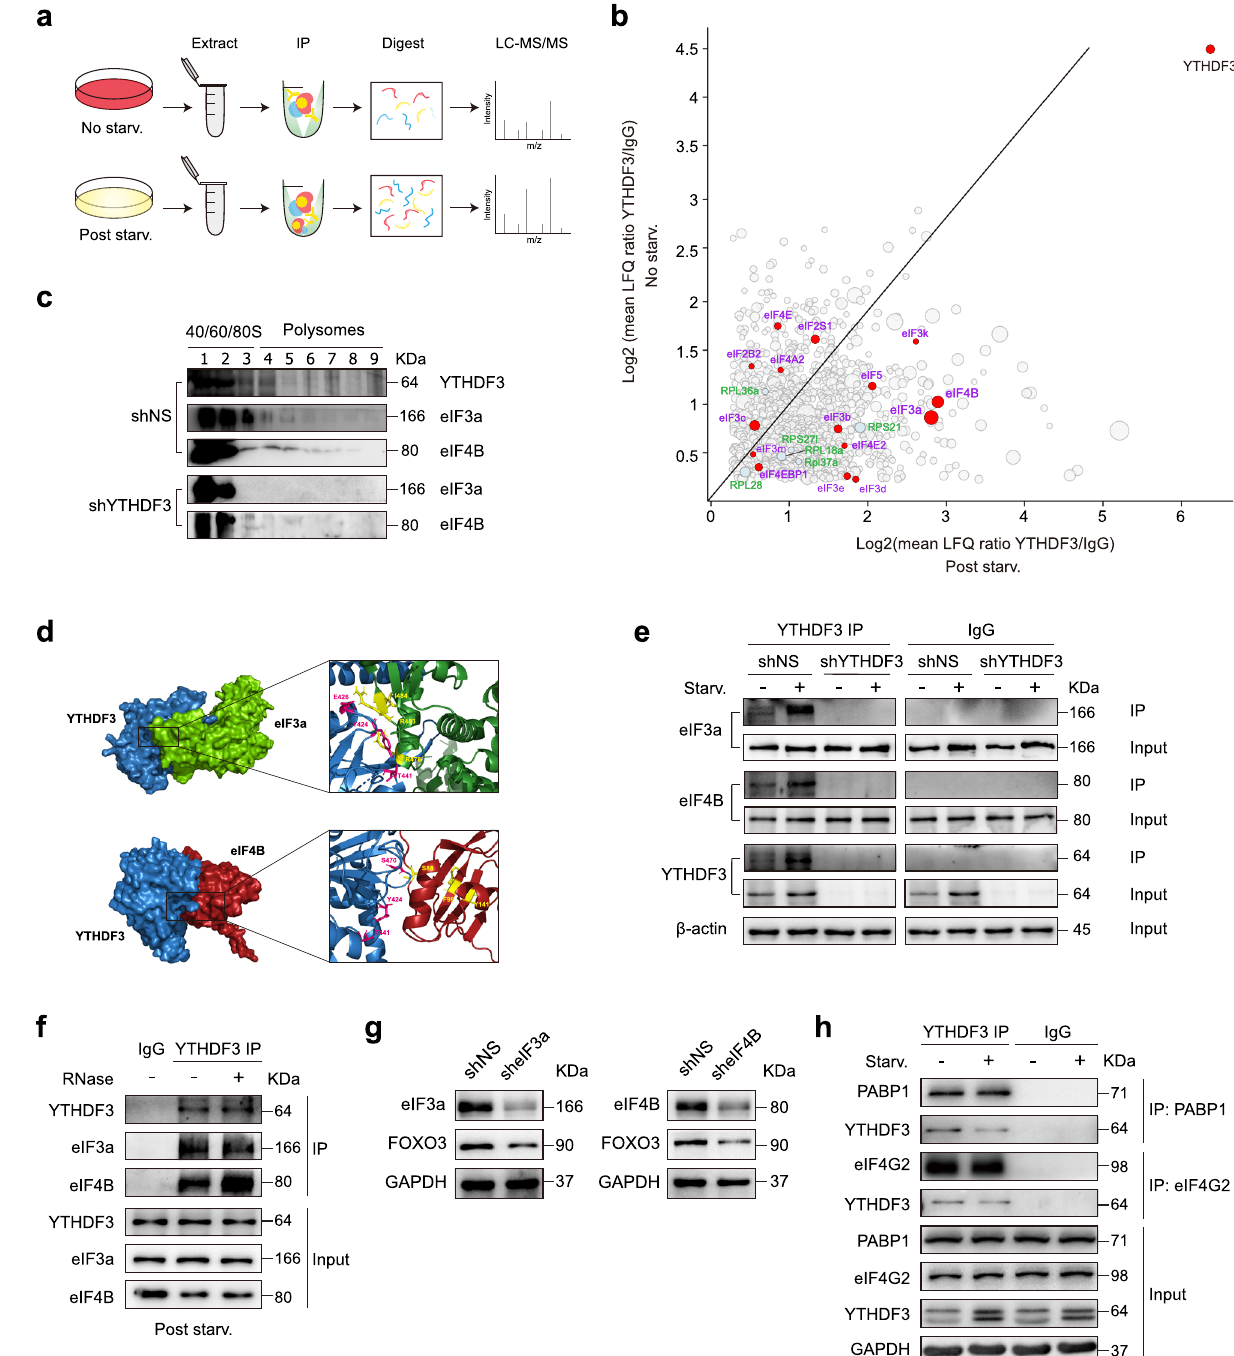
Fig. 8 | YTHDF3 interactswith eIF3a and eIF4B topromote FOXO3translation. a YTHDF3 immunoprecipitation work fl ow in MEFs under normal and nutrient-free conditions. b YTHDF3-speci fi c interactors were identi fi ed through quantitative mass spectrometry. eIFs are labeled in red. 40S and 60S ribosomal subunits are labeled in light blue. Diameters correlate with mean numbers of unique peptides ( n =2). c Immunoblot analyses for eIF3a and eIF4B proteins from polysome frac- tions in shNS and shYTHDF3 MEFs. d Surface view of docked YTHDF3-eIF3a and YTHDF3-eIF4B complexes. YTHDF3, eIF3a, and eIF4B are colored in blue, green, andred,respectively.Inset,magni fi edviewsoftheinteractingresiduesaredrawnin stick representation and labeled (in pink for YTHDF3 and in yellow for eIF3a or